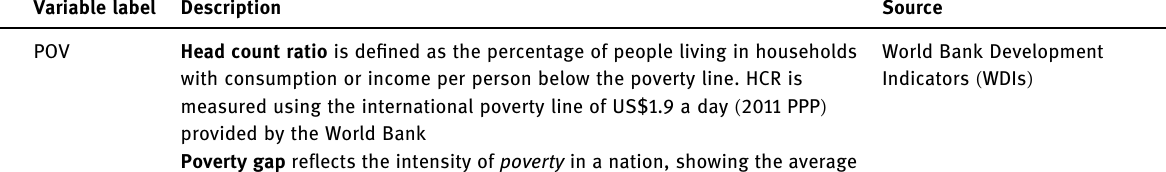
Table A1: Variable description and data sources Variable label